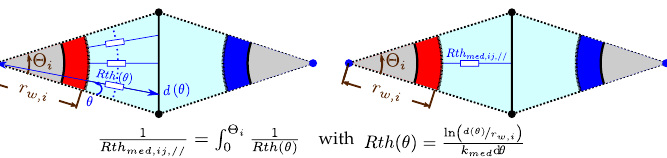
Figure 8. Determination of parallel thermal resistance in a Voronoï